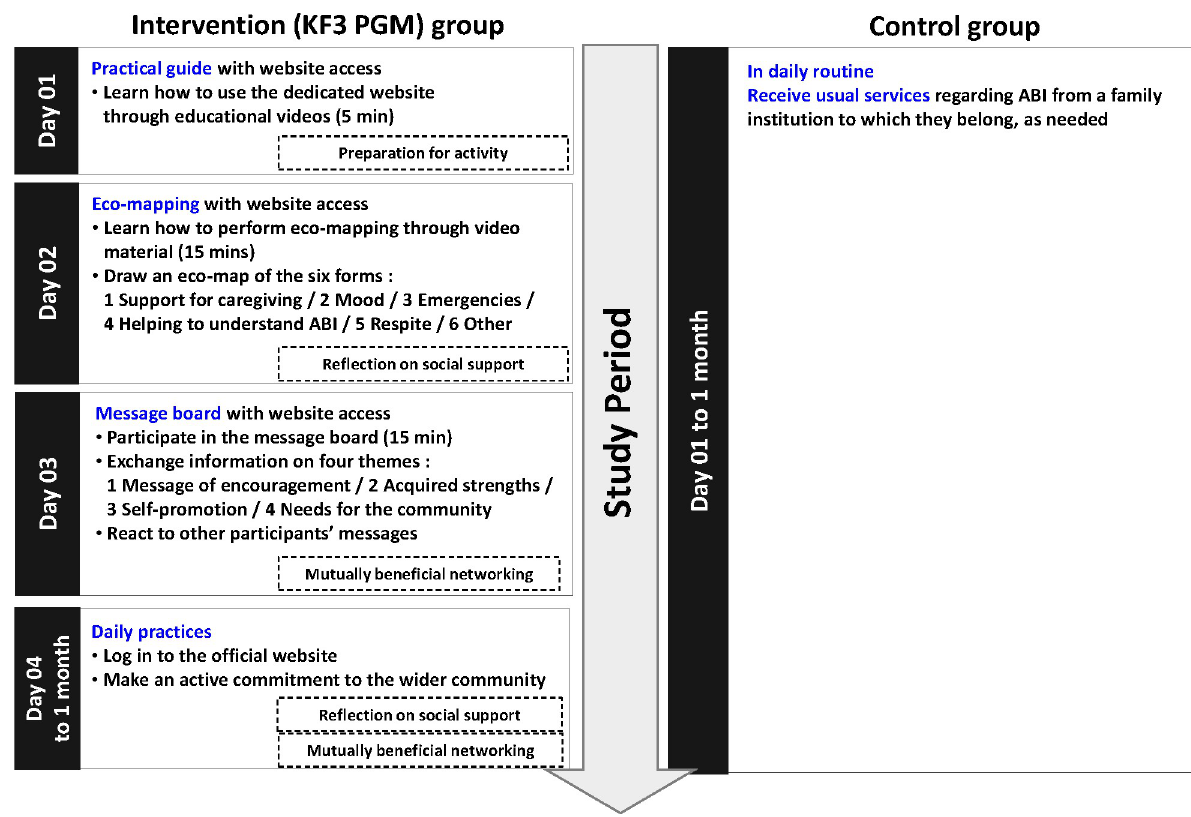
Fig 2. Intervention process in each